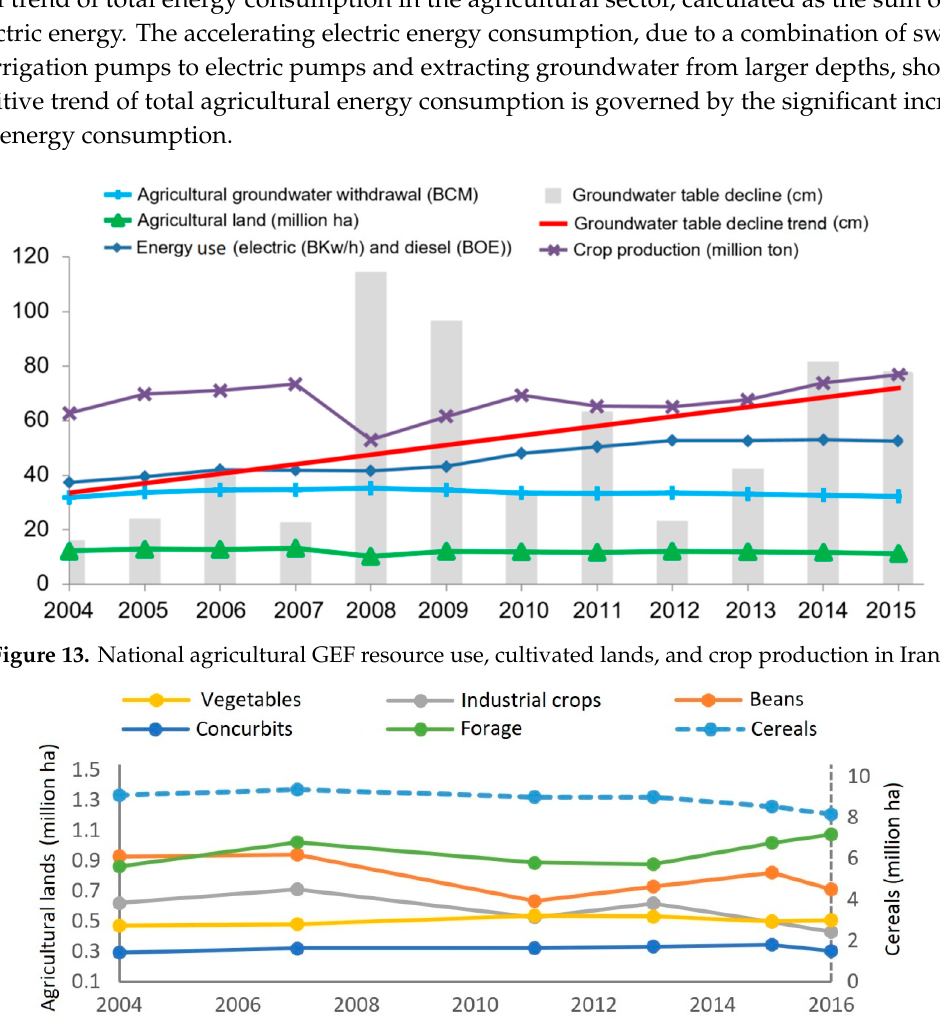
Figure 14. Acreages of agronomic crops in Iran. Rice acreage is included in cereals.